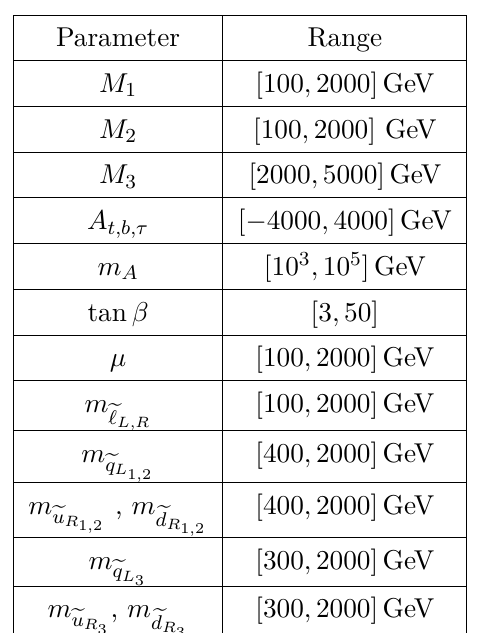
Figure 6. Anapole moment (normalized to the nucleon magneton) for simplified MSSM scenarios with mixed bino-higgsino (left) and wino-higgsino (right) lightest neutralino For details, see sub- section 4.3.